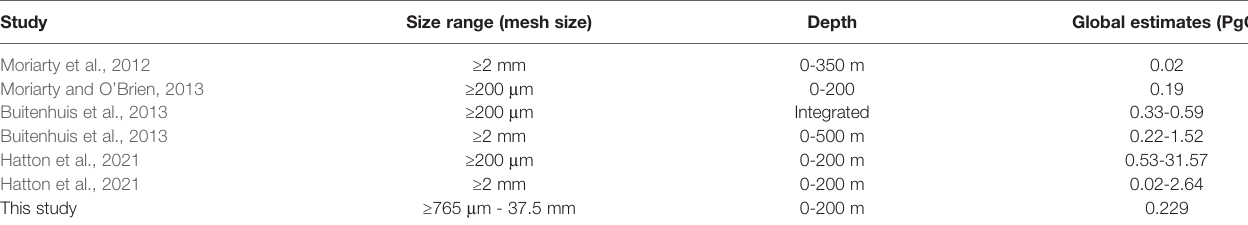
TABLE 2 | Comparison of global biomass estimates in the